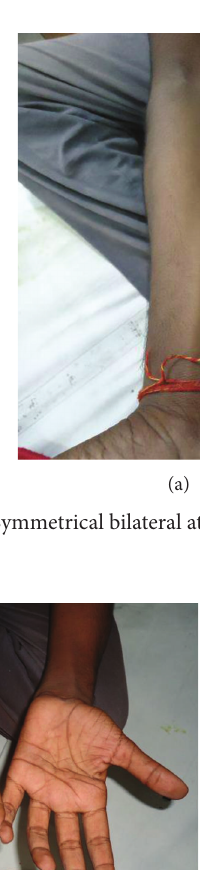
but both biceps and triceps reflex were preserved as was the sensory system of both upper limbs. Examination of bilateral lower limb, higher mental function, cerebellar function, cranial nerves, and spine was normal. There was no finding suggestive of raised intracranial tension. The rest of the systemic examination was unremarkable.